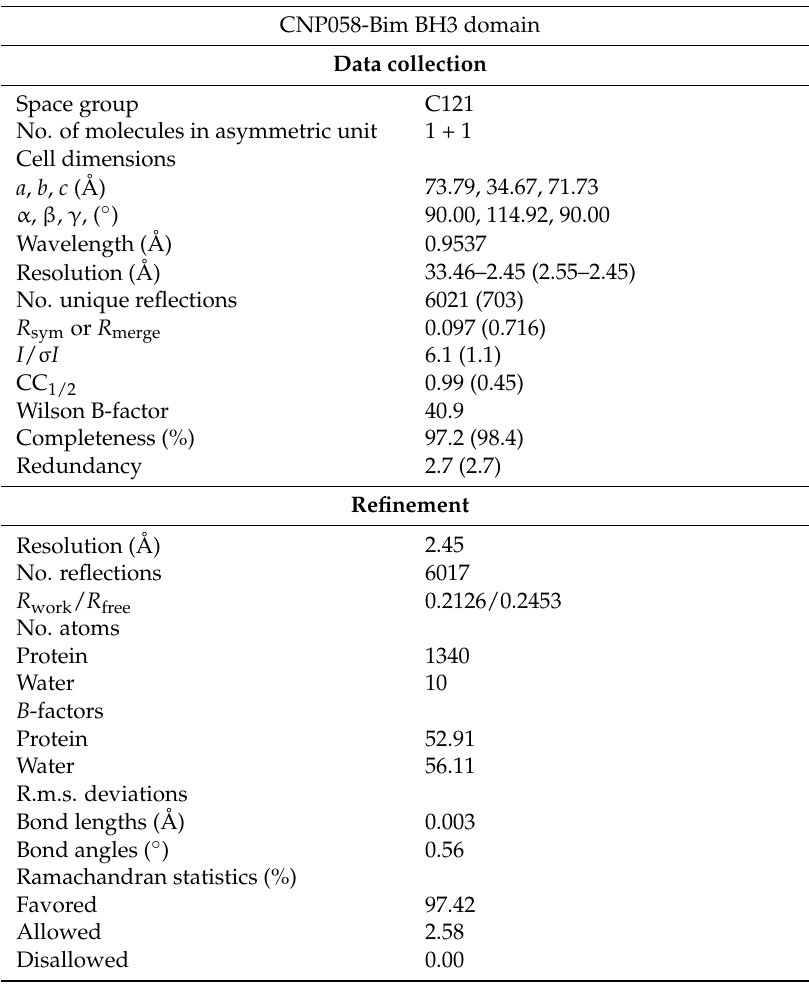
Table 1. Crystallographic data collection and refinement